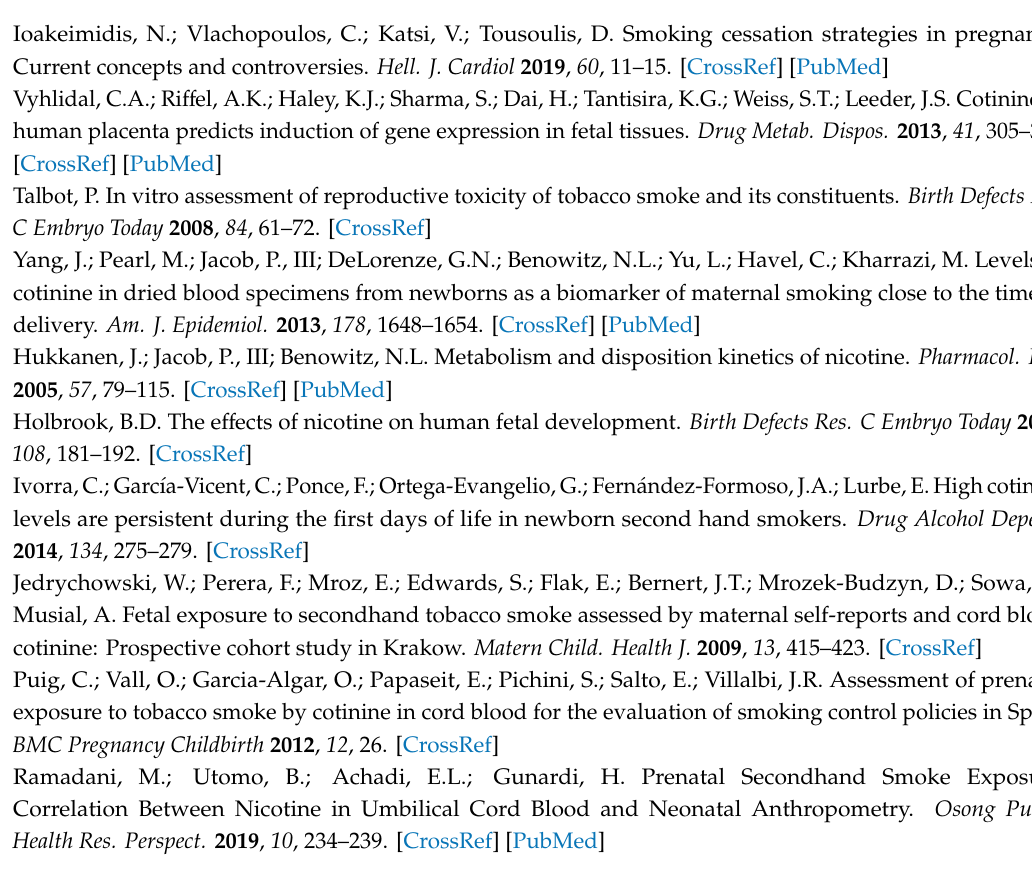
Figure S1 (a): Pairwise scatter plot of nicotine and its metabolites levels in maternal sera (F0 mothers of F1); Figure S1 (b): Pairwise scatter plot of nicotine and its metabolites levels in cord sera (F2); Figure S2: The substantial overlapofCpGsassociatedwithcotinine, norcotinine, andhydroxycotininelevelsinsera; TableS1: SignificantCpGs and their linked genes associated with cotinine (sheet 1), norcotinine (sheet 2), and hydroxycotinine (sheet 3) in maternal (F0 generation) and cord sera (F2